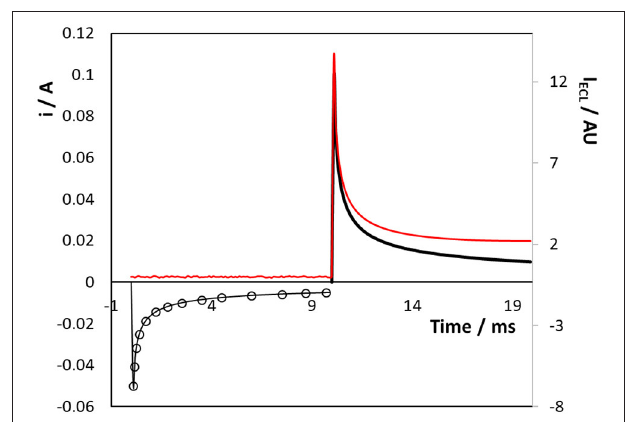
FIGURE 4 | Transient current (black line) and ECL (red line) responses for the 3D titanium array coated with a native oxide following potential steps from 0.000 to + 1.200V (0–10ms) and then to − 1.600V (10–20ms) vs. Ag/AgCl. Reduction currents are positive. The supporting electrolyte is aqueous 0. 1M H 2 SO 4